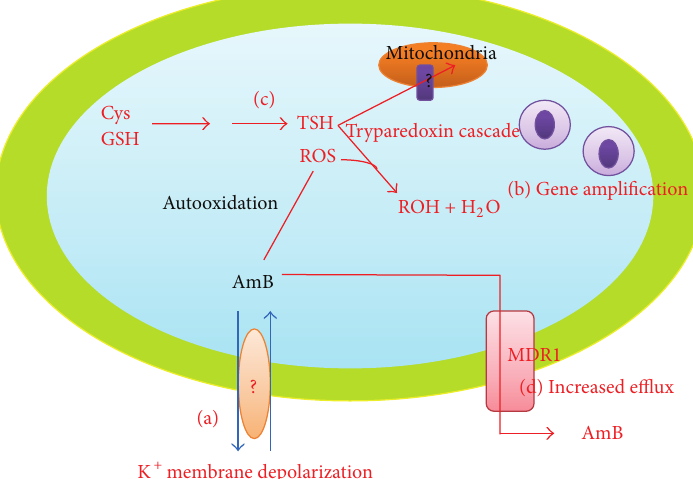
Figure 2: The mechanisms of amphotericin B resistance in Leishmania. (a) Change in membrane fluidity results in blocking of the drug entry inside the cell. The membrane transporters or factors responsible for such changes in membrane depolarization are still unknown. (b) Gene amplification of genes to confer resistance. (c) Activation of tryparedoxin cascade to prevent the oxidative damage caused by the drug. (d) Drug efflux through various membrane-bound pumps like